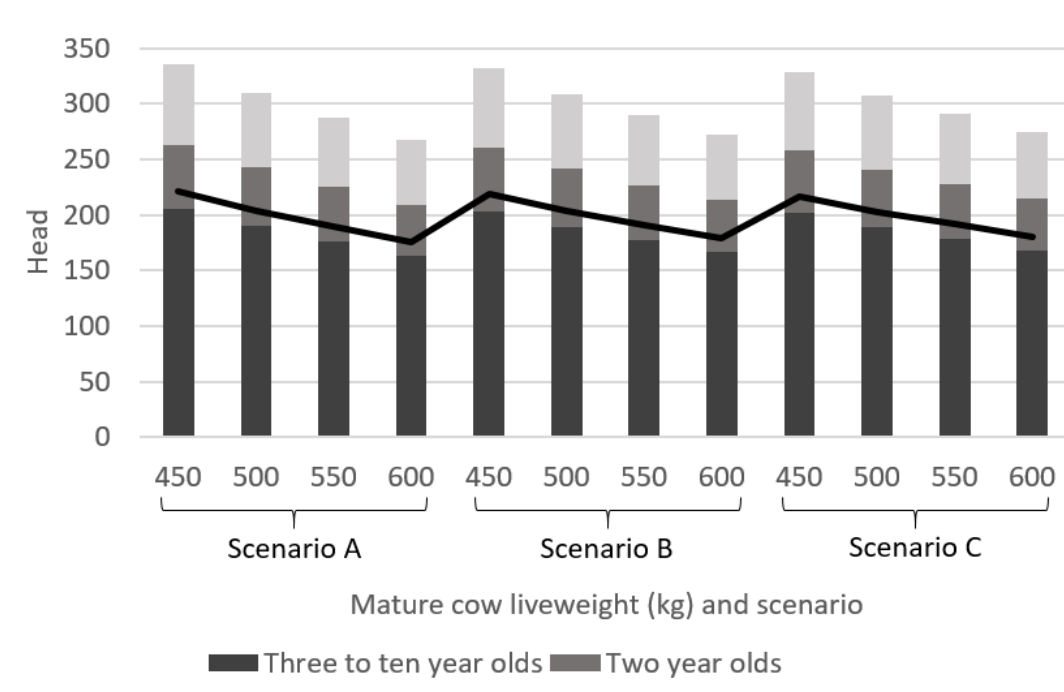
Figure 3. Numbers of cows of differing ages in the herd and numbers of calves weaned, with varying mature cow liveweight for scenarios with (A) a constant ratio of birth and weaning weights to mature cow liveweight; (B) decreasing ratios of birth and weaning weights to mature cow liveweight as mature cow liveweight increased; and (C) decreasing ratio of birth weight to mature cow liveweight as mature cow liveweight increased and constant pre-weaning growth rates of 1.00 kg/day.